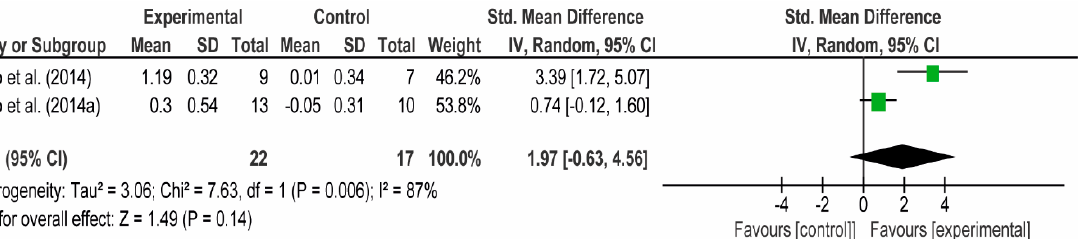
Figure 13. The effect size of isometric maximal voluntary co-contraction training on the elbow extensors MT. References for the studies in the table with the same publication year are Maeo et al. (2014) [83], Maeo et al. (2014a) [84].